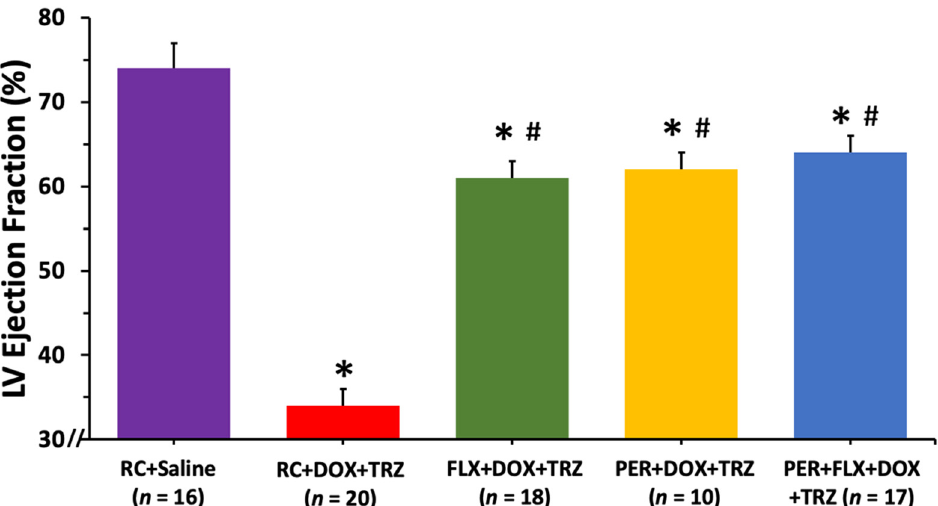
Figure 3. Changes in LVEF values at study endpoint in mice prophylactically administered FLX, PER, or FLX + PER treated with DOX + TRZ. Female C57Bl/6 mice treated with RC + DOX + TRZ experienced significantly impaired left ventricular systolic function as evident by a drop in LVEF at week 6. Prophylactic treatment with FLX, PER, or FLX + PER significantly improved the LVEF in animals administered DOX + TRZ. Data are expressed as mean ± SD. * p < 0.05 RC + DOX + TRZ vs. RC + saline. * # p < 0.05 FLX + DOX + TRZ or PER + DOX + TRZ or PER + FLX + DOX + TRZ vs. RC + DOX + TRZ and RC + saline. DOX, doxorubicin; FLX, flaxseed; LV, left ventricle; PER, perindopril; RC, regular chow; SD, standard deviation; TRZ, trastuzumab. Table 1. Echocardiographic parameters at baseline and 6 weeks.